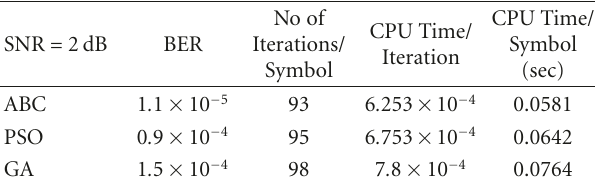
Table 2: Comparison of MUDs in terms of CPU time